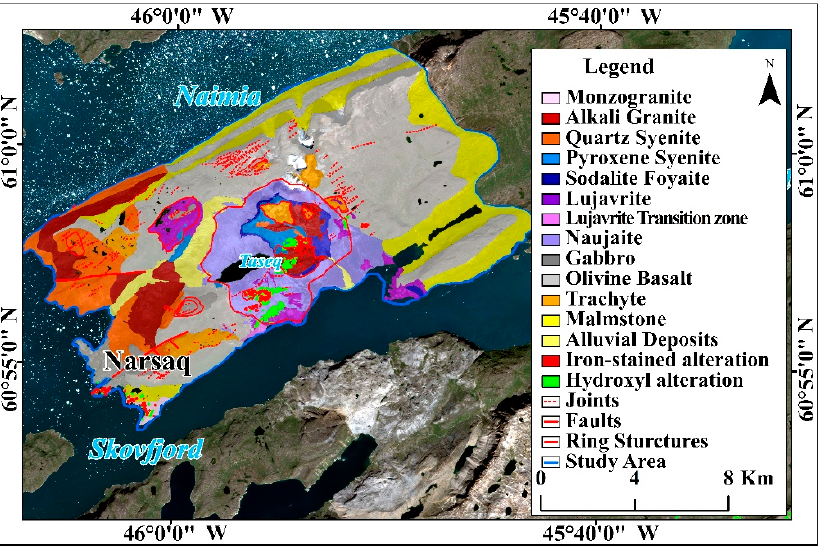
Figure 7. Interpreted map of remote sensing geological background information map (the base image is a combination of the 432 Sentinel-2 bands).